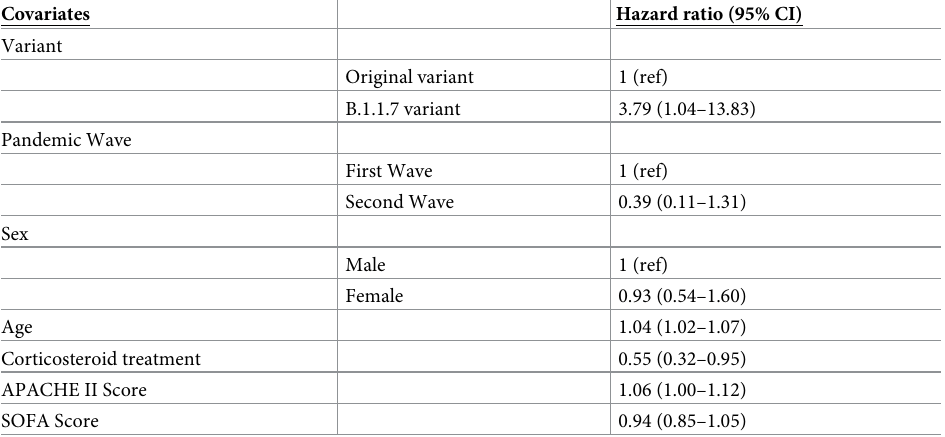
Table 3. Cox proportional risk analysis for mortality of all intubated and ventilated patients by B.1.1.7 and the original